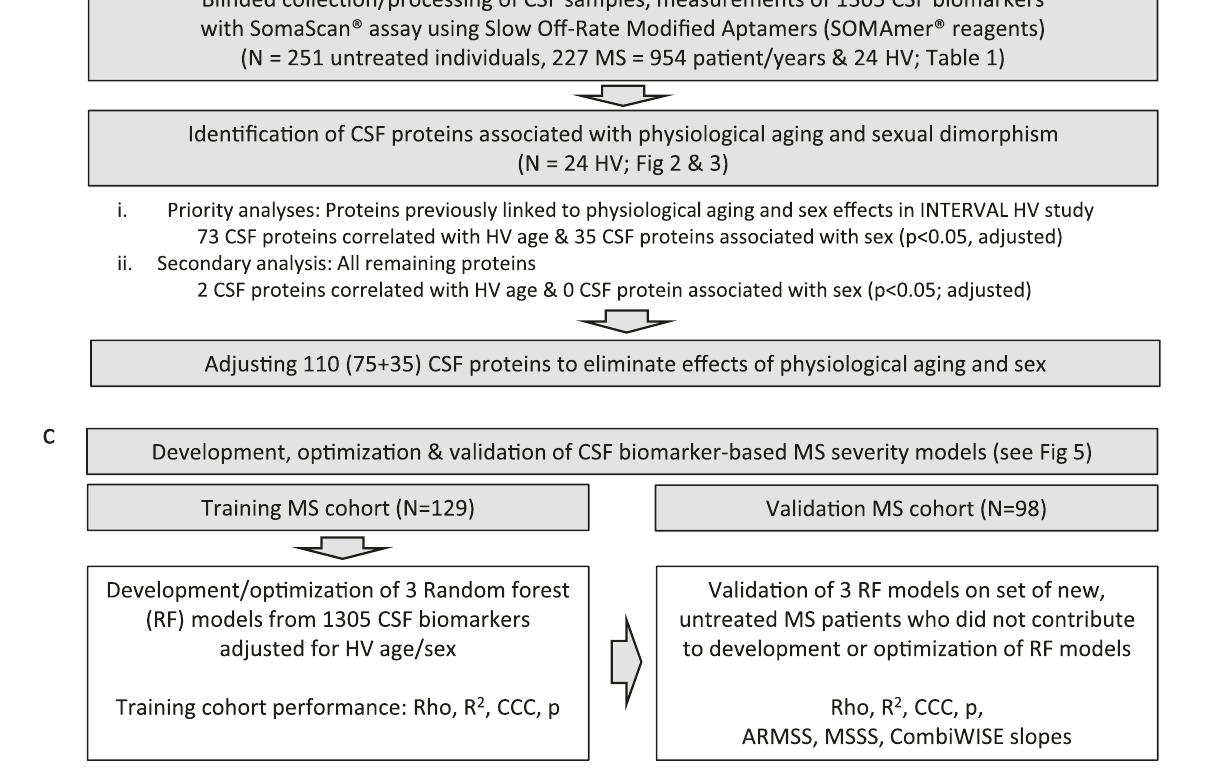
Fig. 1 | Experimental design. a Prospective collection of longitudinal clinical (Expanded Disability Status Scale [EDSS], Combinatorial Age-adjusted Disability Score [CombiWISE]), and cross-sectional imaging outcomes (brain parenchymal fraction (BPFr]) paired with lumbar puncture (LP) at the fi rst clinic visit. b 1305 biomarkers measured in blinded fashion in cerebrospinal fl uid (CSF) samples of multiple sclerosis (MS) patients and healthy volunteers (HV) were mathematically adjusted to eliminate the effects of aging and sex. c Random forest (RF) algorithm